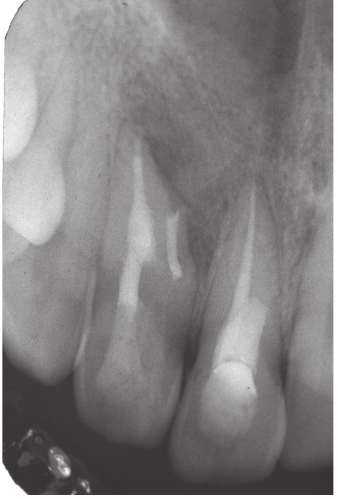
Figure 6: 1-year postoperative